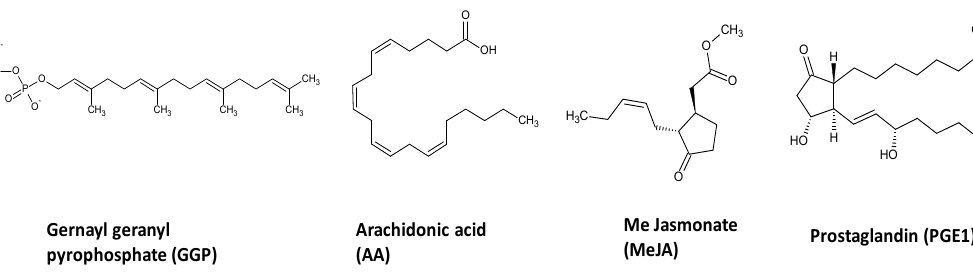
Figure 2. Chemical structure of GGP and the oxylipins used for eliciting soft corals.